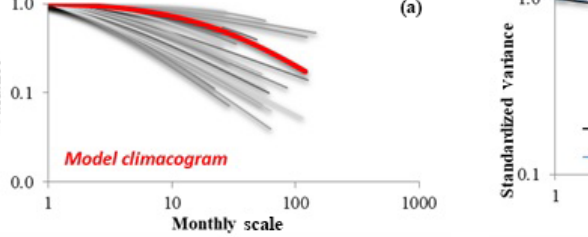
Figure 3. Climacogram for tides (a) and currents (b)